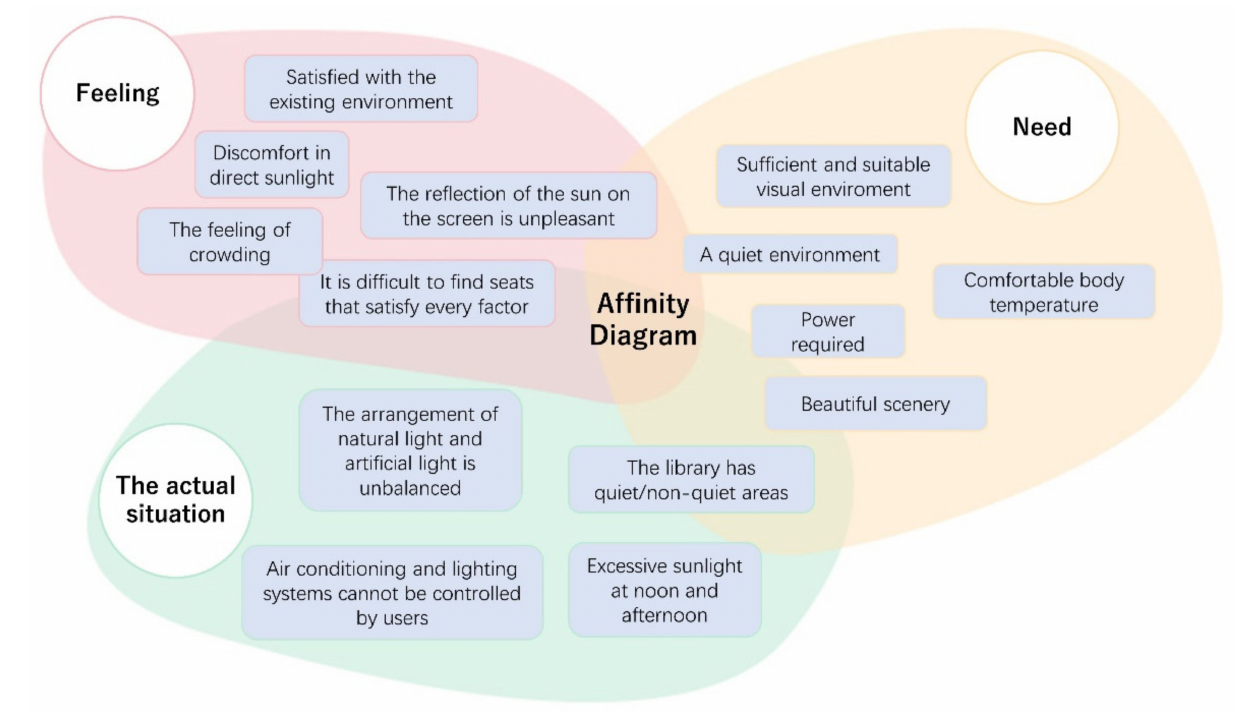
Figure 8. The affinity